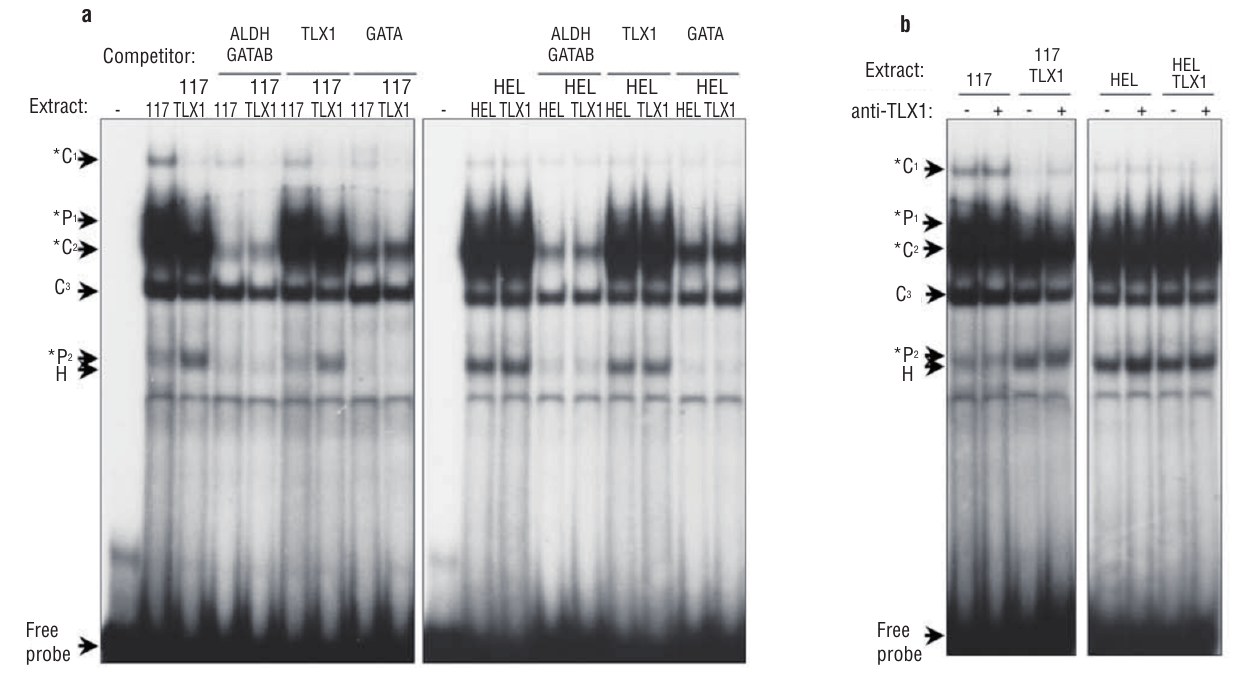
Figure 5. Perturbation of GATA-containing complexes by TLX1. (A) GATA factor(s) but not TLX1 binds to the ALDH1A1 promoter GATA box. EMSA using a 32P-labeled double-stranded oligonucleotide containing the GATAAA site at -33 of the human ALDH1A1 promoter (ALDH GATAB). The assay was performed with nuclear extracts prepared from PER-117 (left panel) or HEL cells (right panel) with and without overexpression of TLX1. The migration of the free probe is indicated along with the positions of specific DNA- protein complexes (C1, C2, P1 and P2 in PER-117 cells; C1, C2 and H in HEL cells). Overbars denote the addition of a 35-fold molar excess of unlabeled double-stranded self (ALDH GATAB), satellite 2 DNA (TLX1) or GATA consensus (GATA) probe as competitor. Asterisks denote complexes altered by TLX1. (B) TLX1 directly disrupts the low mobility ALDH1A1 promoter GATA box complex C1. EMSA performed as above using the -33 GATAAA site oligonucleotide (ALDH GATAB) in the absence (-) or presence (+) of TLX1 anti- body. The migration of the free probe is indicated along with the positions of specific DNA-protein complexes (C1, C2, P1 and P2 in PER-117 cells; C1, C2 and H in HEL cells). Complex C1 reappears in PER-117 cells expressing TLX1 in the presence of anti-TLX1 antibody